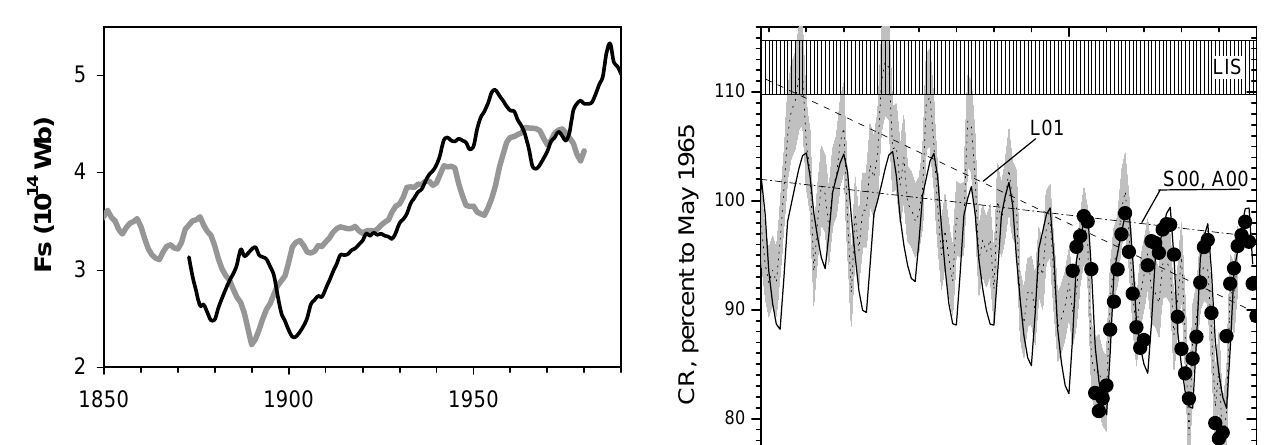
Fig. 1. The coronal source flux F s calculated by the method of Lockwood et al. (1999) from the geomagnetic aa series (black curve) and reconstructed from the 10 Be series (grey curve). The curves are 11-year running mean values.